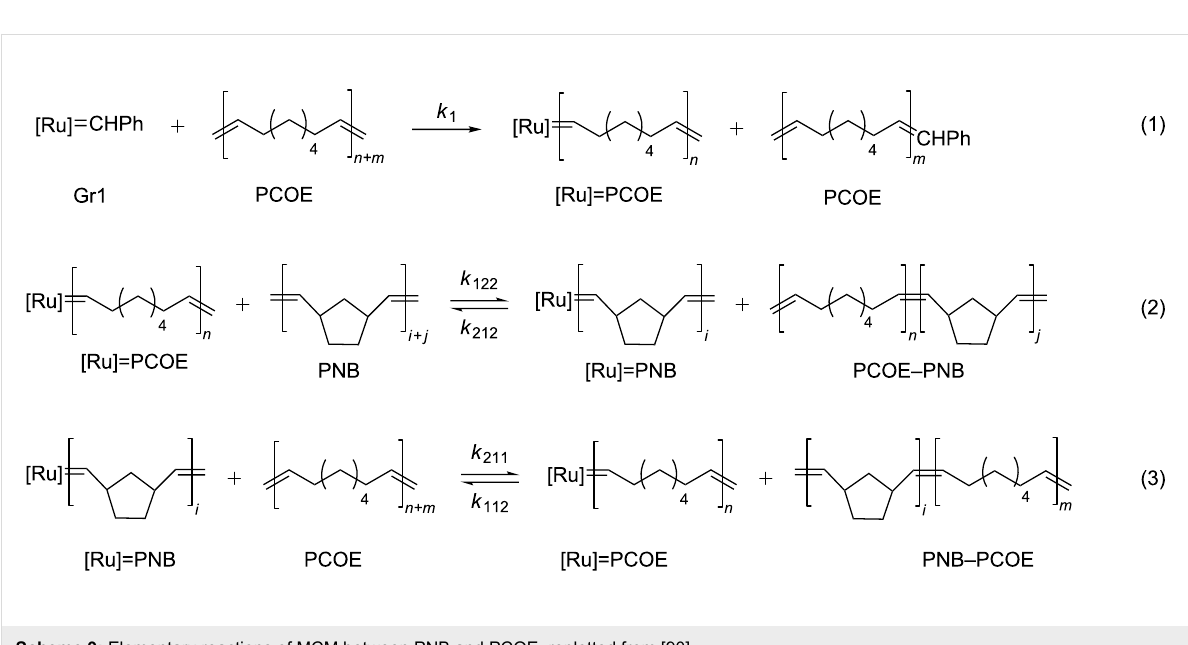
Scheme 9: Elementary reactions of MCM between PNB and PCOE, replotted from